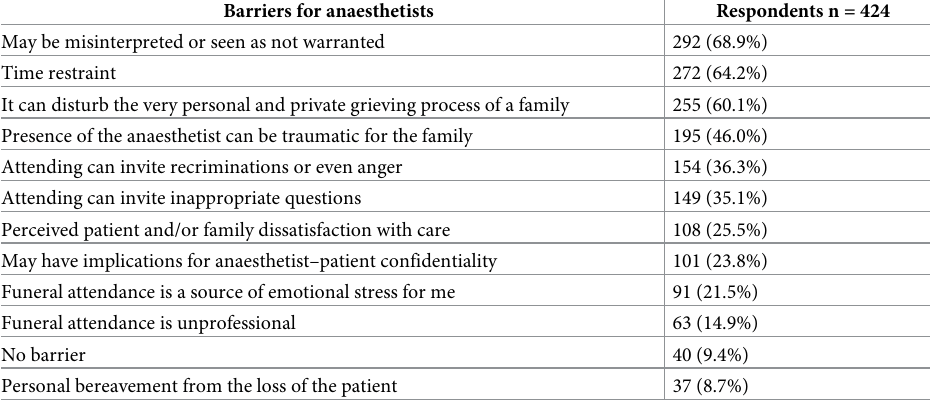
Table 3. Perceived barriers to anaesthetists attending a patient’s